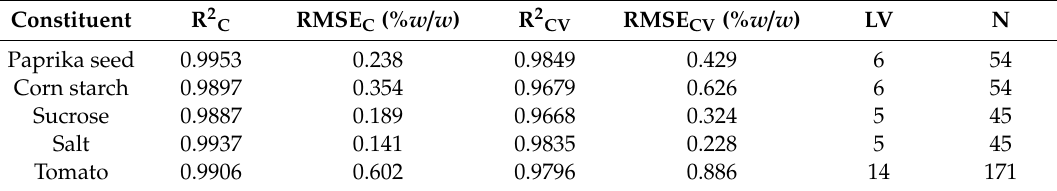
Table 7. Adulterant concentration prediction with PLSR and leave-one-sample-out cross-validation (LOSOCV) validation on pre-treated NIRS spectra of authentic and adulterated tomato pastes in the wavelength range of 950–1690 nm.